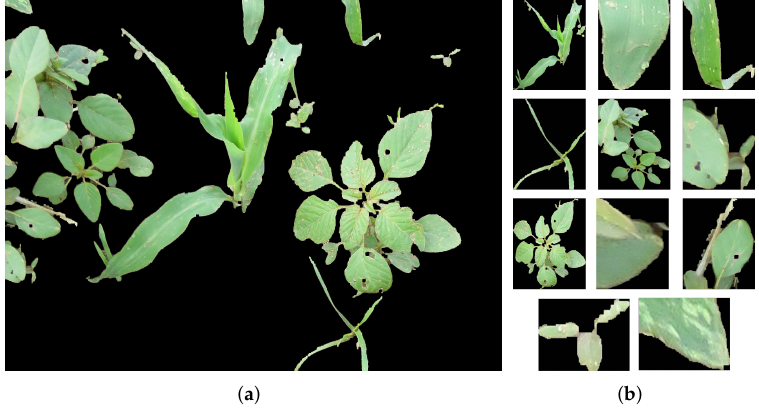
Figure 5. Plant extraction from segmented image. ( a ) Input image. ( b ) Set of different classes. Table 1. Plant species that integrate the experimental dataset.